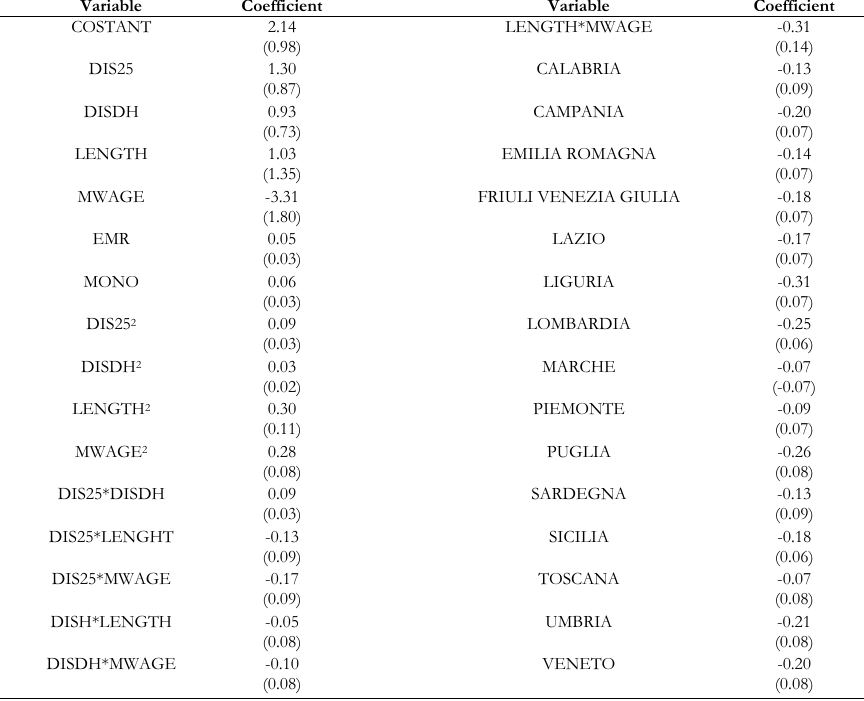
Estiamtes for our preferred (Model 2) cost frontier model (standard errors are displayed in